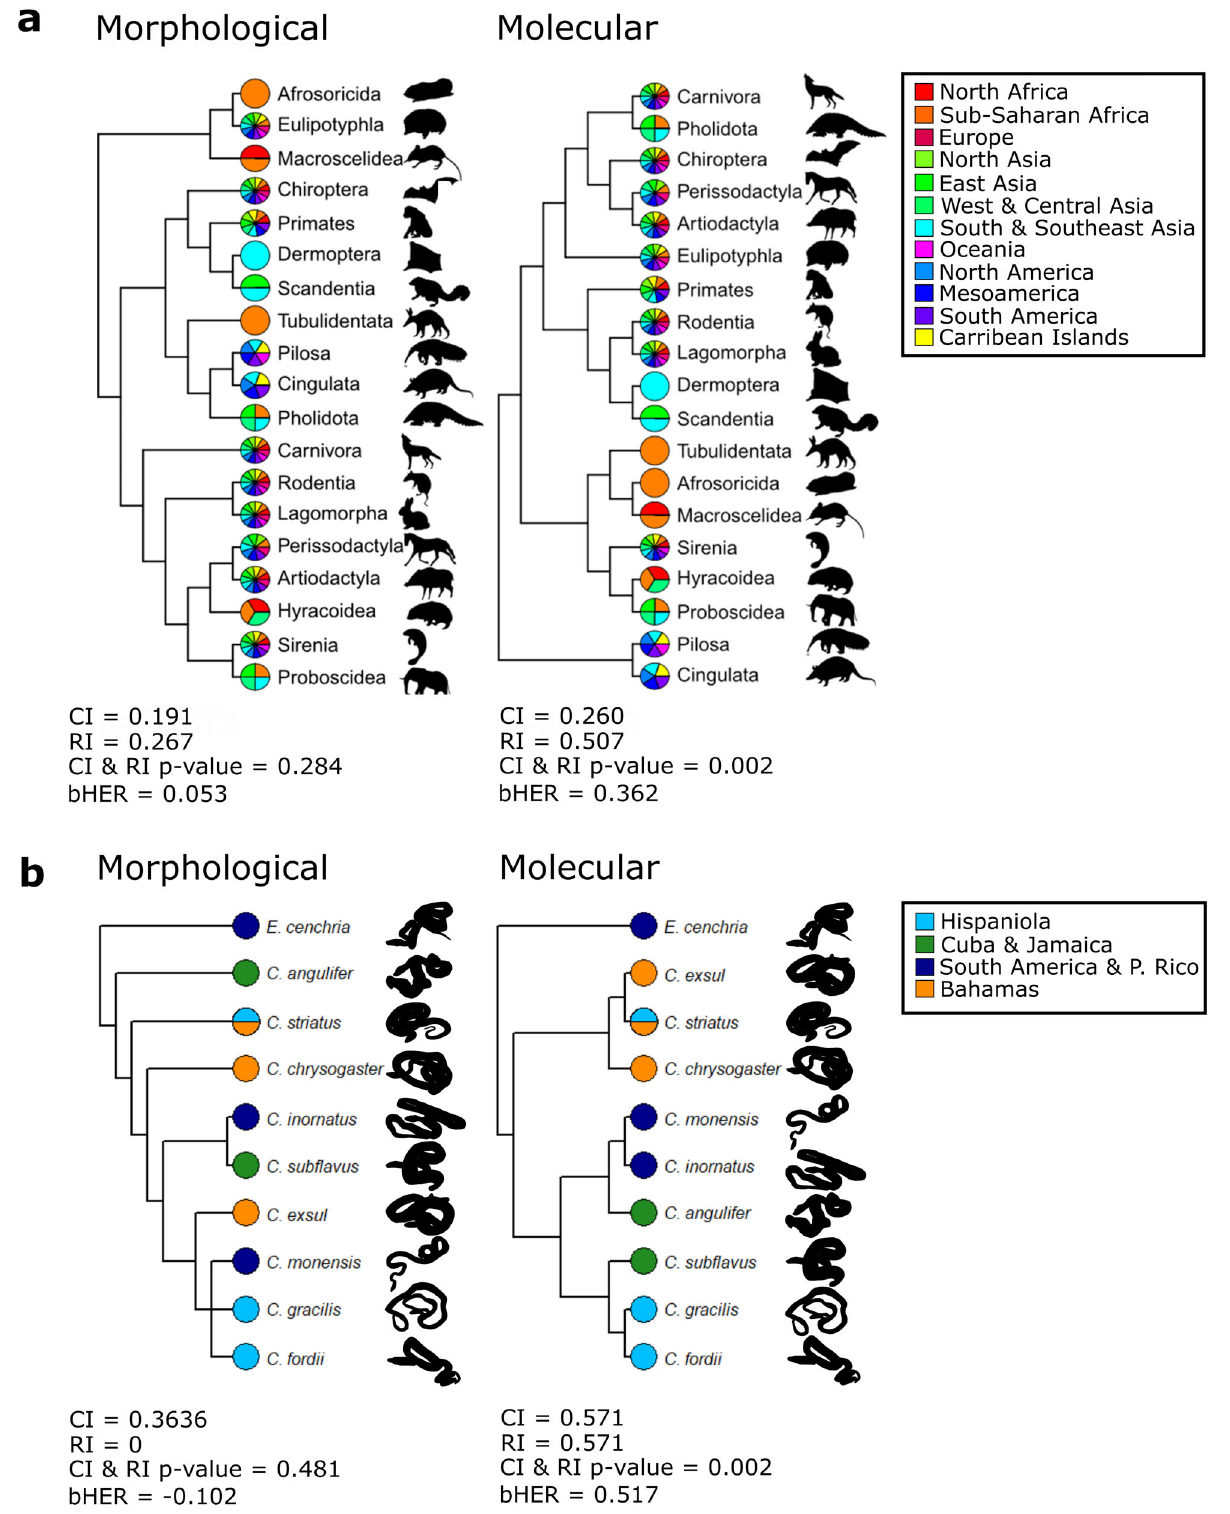
Fig. 2 Biogeographic congruence in morphological and molecular phylogenies. Binary biogeographic region characters mapped onto paired morphological and molecular phylogenies. a Placental mammals (Eutheria) from O ’ Leary et al. 2013 100 . b Caribbean boas ( Chilabothrus / Epicrates ), with the morphological tree taken from Kluge 1989 101 and the molecular tree taken from Tolson 1987 102 . Regions for which the terminal taxon is coded present are represented as coloured pie slices. Consistency index (CI), retention index (RI) and biogeographic HER (bHER) values given are for the matrix of biogeographic region presences and absences, while CI & RI p value is calculated using 10,000 randomly permuted region